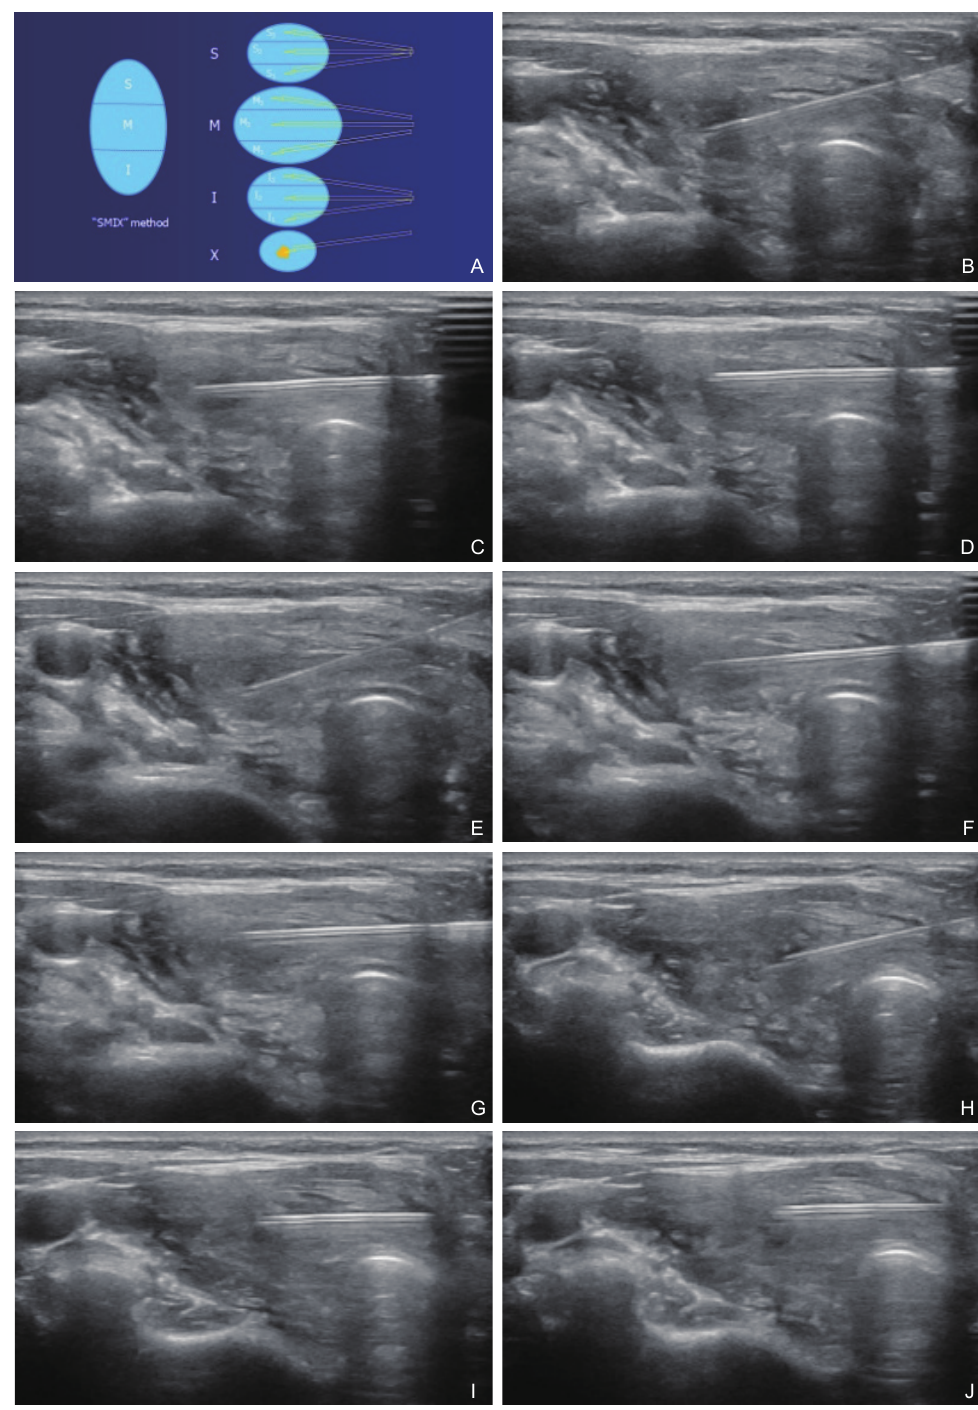
Figure 18 The “9+X needle tracks" puncture mode. (A) Diagram of “9+X needle tracks" puncture mode; (B~D) Ultrasonogram of sampling in three zones of the upper subarea (S) of the nodule ; (E~G) Ultrasonogram of sampling in three zones of the middle subarea (M) of the nodule ; (H~J) Ultrasonogram of sampling in three zones of the lower subarea (I) of the